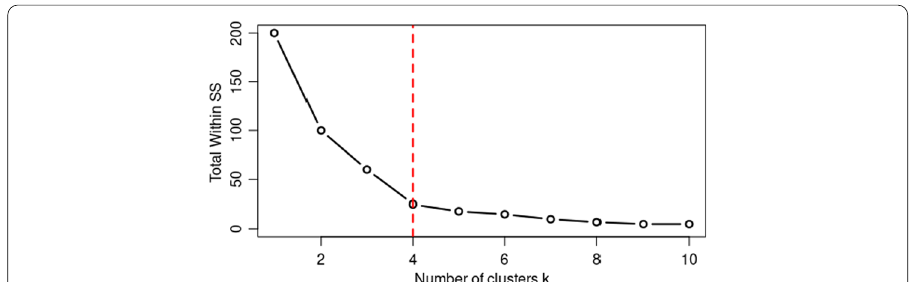
Fig. 1 Example for Elbow plot to check optimal number of clusters (k). Red line indicates the elbow joint and it will help to find k